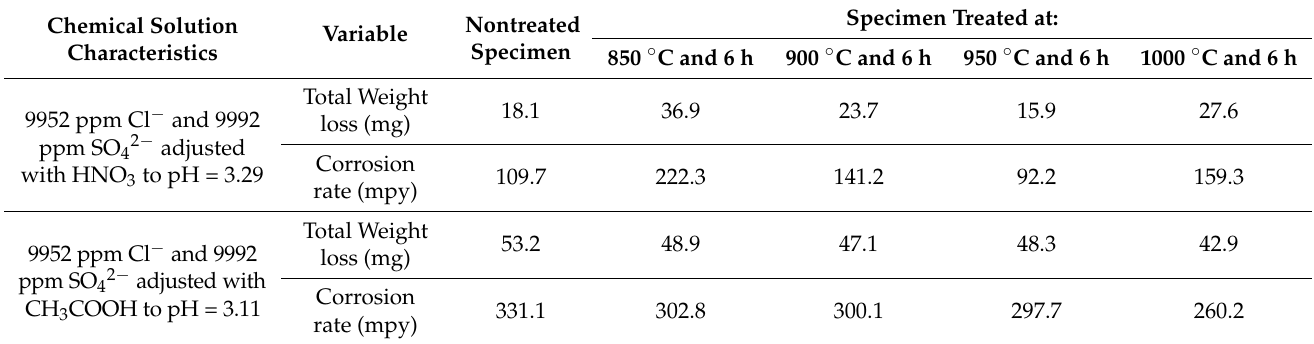
Table 6. Weight loss and corrosion rate